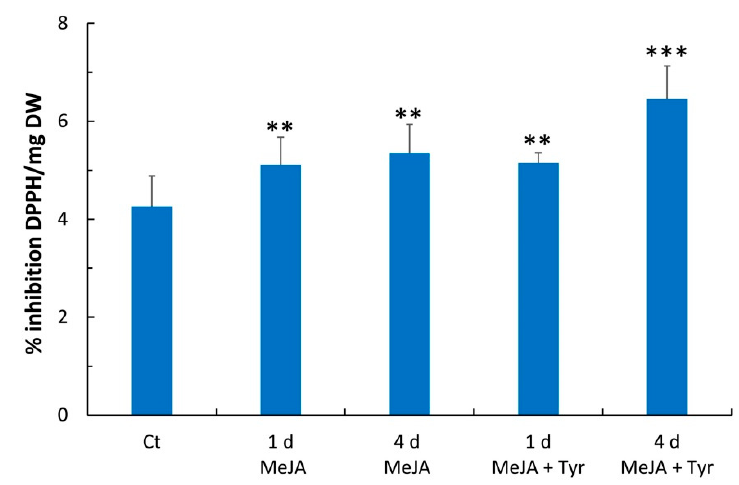
Figure 5. DPPH radical scavenging activity of the extracts from hemp cell suspensions subjected to different elicitation treatments. Ct: control; 1 d: 1 day; 4 d: 4 days; MeJA: methyl jasmonate; Tyr: tyrosine; DPPH: 2,2-diphenyl-1-picrylhydrazyl; DW: dry weight. Comparisons of differences between the means of the treated and Ct samples were performed using Student’s t -tests (* p ≤ 0.05; ** p ≤ 0.01; *** p ≤ 0.001). Each value represents the average of three biological replicates ± SD.